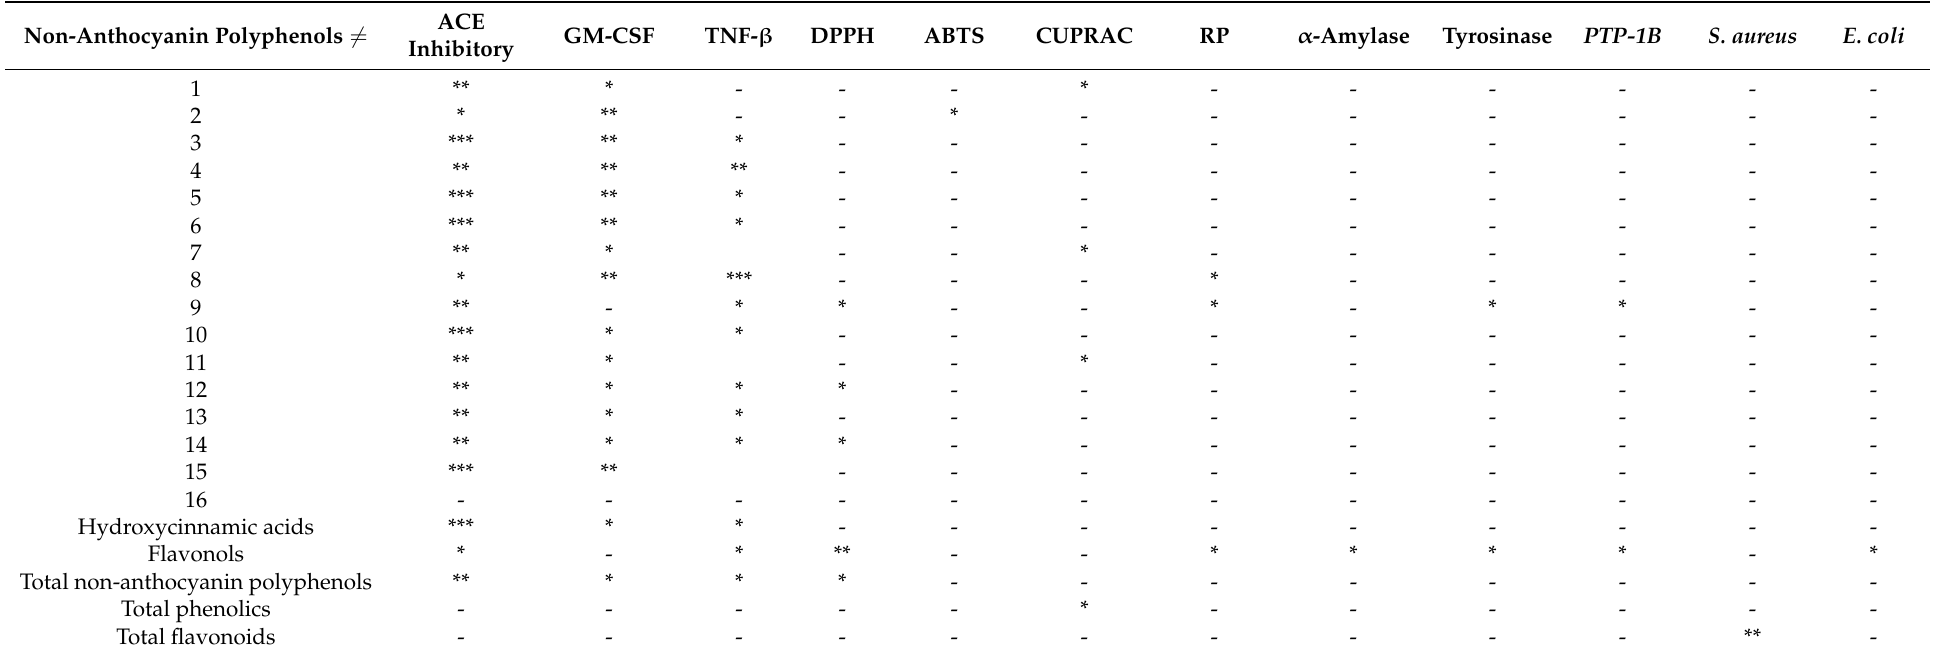
Table 2. Correlation analysis between non-anthocyanin polyphenols with biological activities of A. trifoliata flower extracts. Non-Anthocyanin Polyphenols (cid:54)